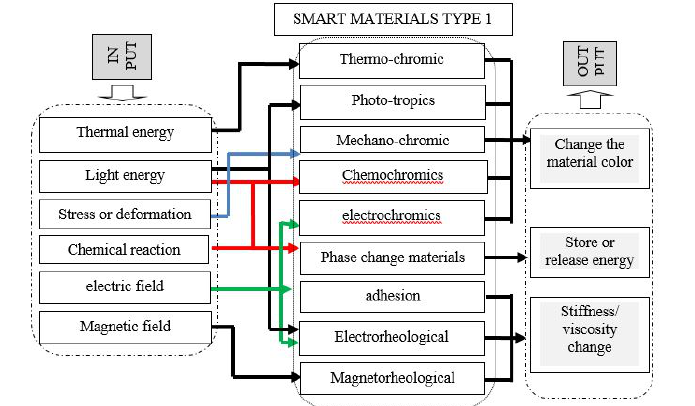
Figure 1. type 1 of smart materials that undergoesproperty change with response to an external energy (Vavan, 2014) edited by the